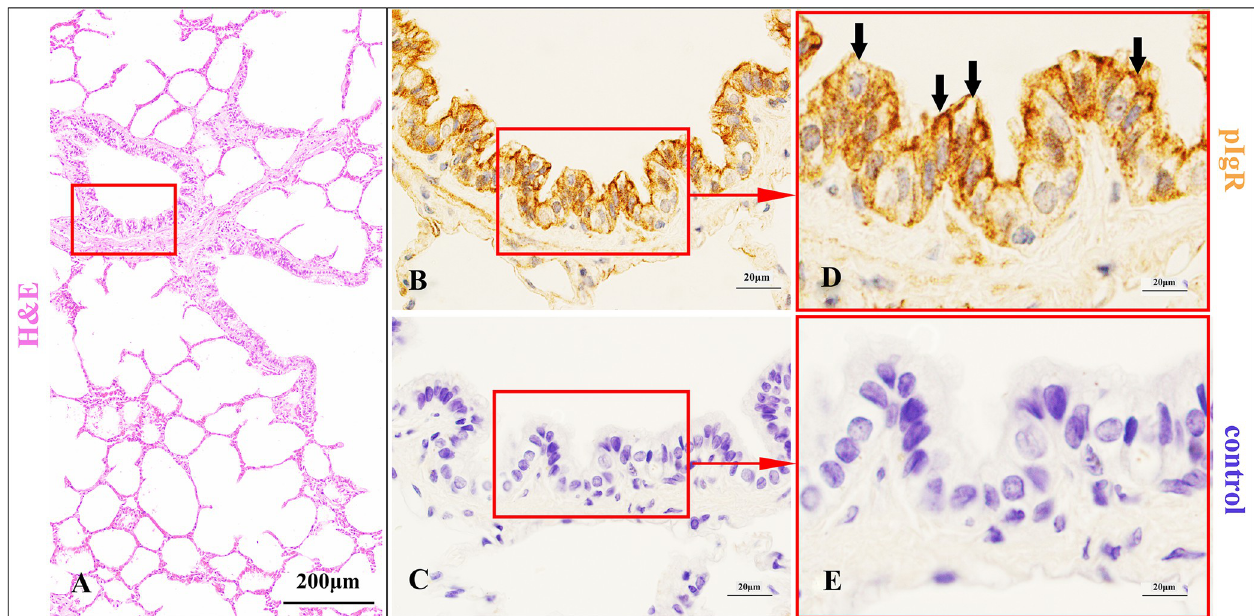
Fig 5. pIgR expression characteristics in terminal bronchial epithelium of Bactrian camels. https://doi.org/10.1371/journal.pone.0264815.g005 magnification: 100 × ; pIgR was mainly in the club cells (arrows) of terminal bronchi (B), stained with pIgR-immunohistochemistry (IHC). Original magnification: 1000 × ; negative control of terminal bronchi epithelium (C), stained with IHC. Original magnification: 1000 × ; pictures (D-E) were representative views of terminal bronchi epithelium from pictures (B-C), and the original magnifications were all 1000 × .